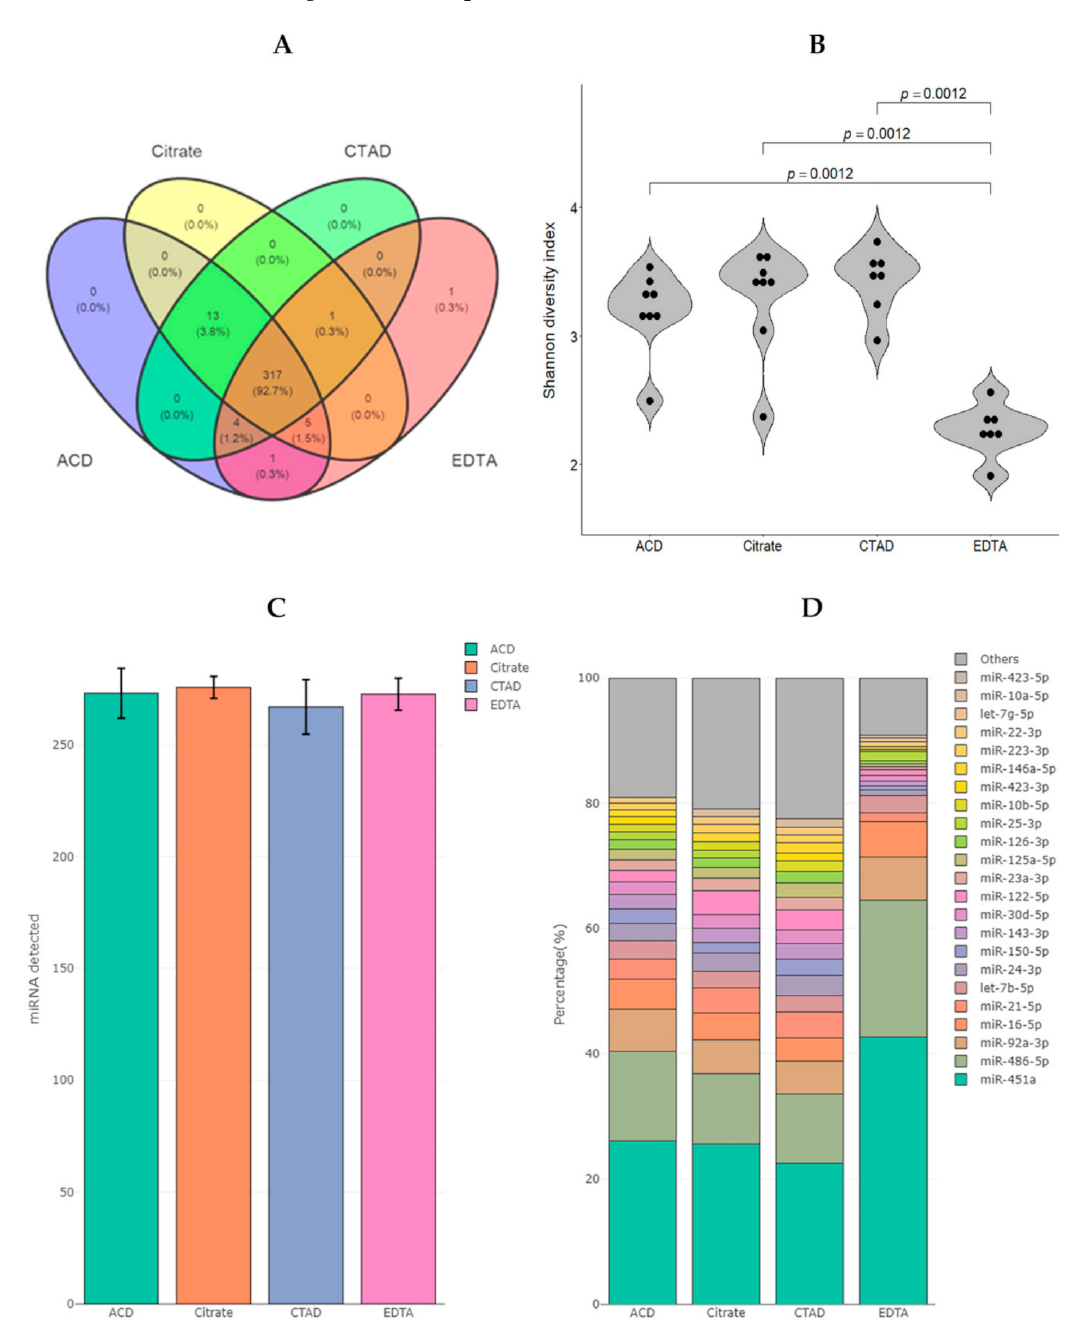
Figure 4. Diversity of miRNAs in plasma samples ( N = 30) obtained using different anticoagulants in blood collection tubes. ( A ) Venn diagram for the total numbers of detected miRNAs with more than 2 counts per million (CPM) in at least 10 samples in the study groups. ( B ) Grouped violin plots reflecting the distribution of the alpha diversity represented by Shannon indices. The dots correspond to individual samples. The Mann-Whitney U test p -values corrected by false discovery rate are given for the statistically significant pairwise comparisons. ( C ) The average number of detected miRNAs per sample in the study groups. Error bars indicate standard error of the mean. ( D ) Representation of the top 20 miRNAs in each study group by CPM